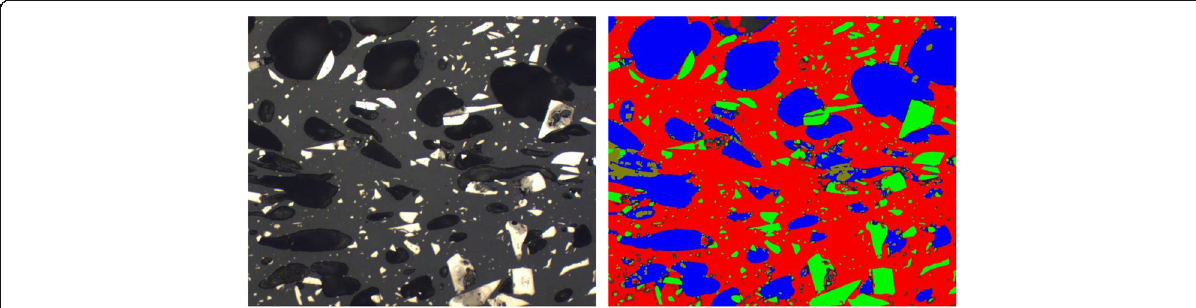
Fig. 11 Image (one of the 19) taken from at X 200 original magnification of the microsection of the PEEK_50NdFeB_3D (left) and result of the rieaboration with the Clemex Technologies Inc. software highlighting the presence of porosities (blue), PEEK matrix (red) and magnetic particles (green)